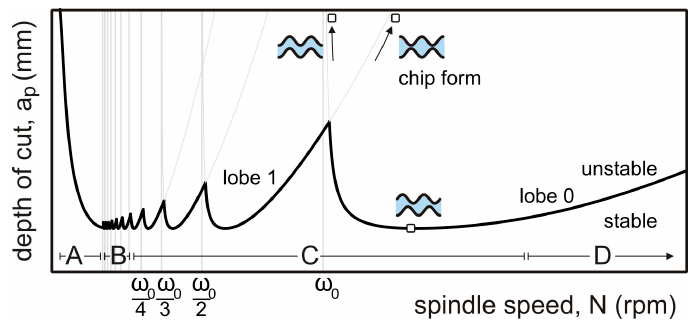
Figure 5. Relative location on the stability lobe diagram .